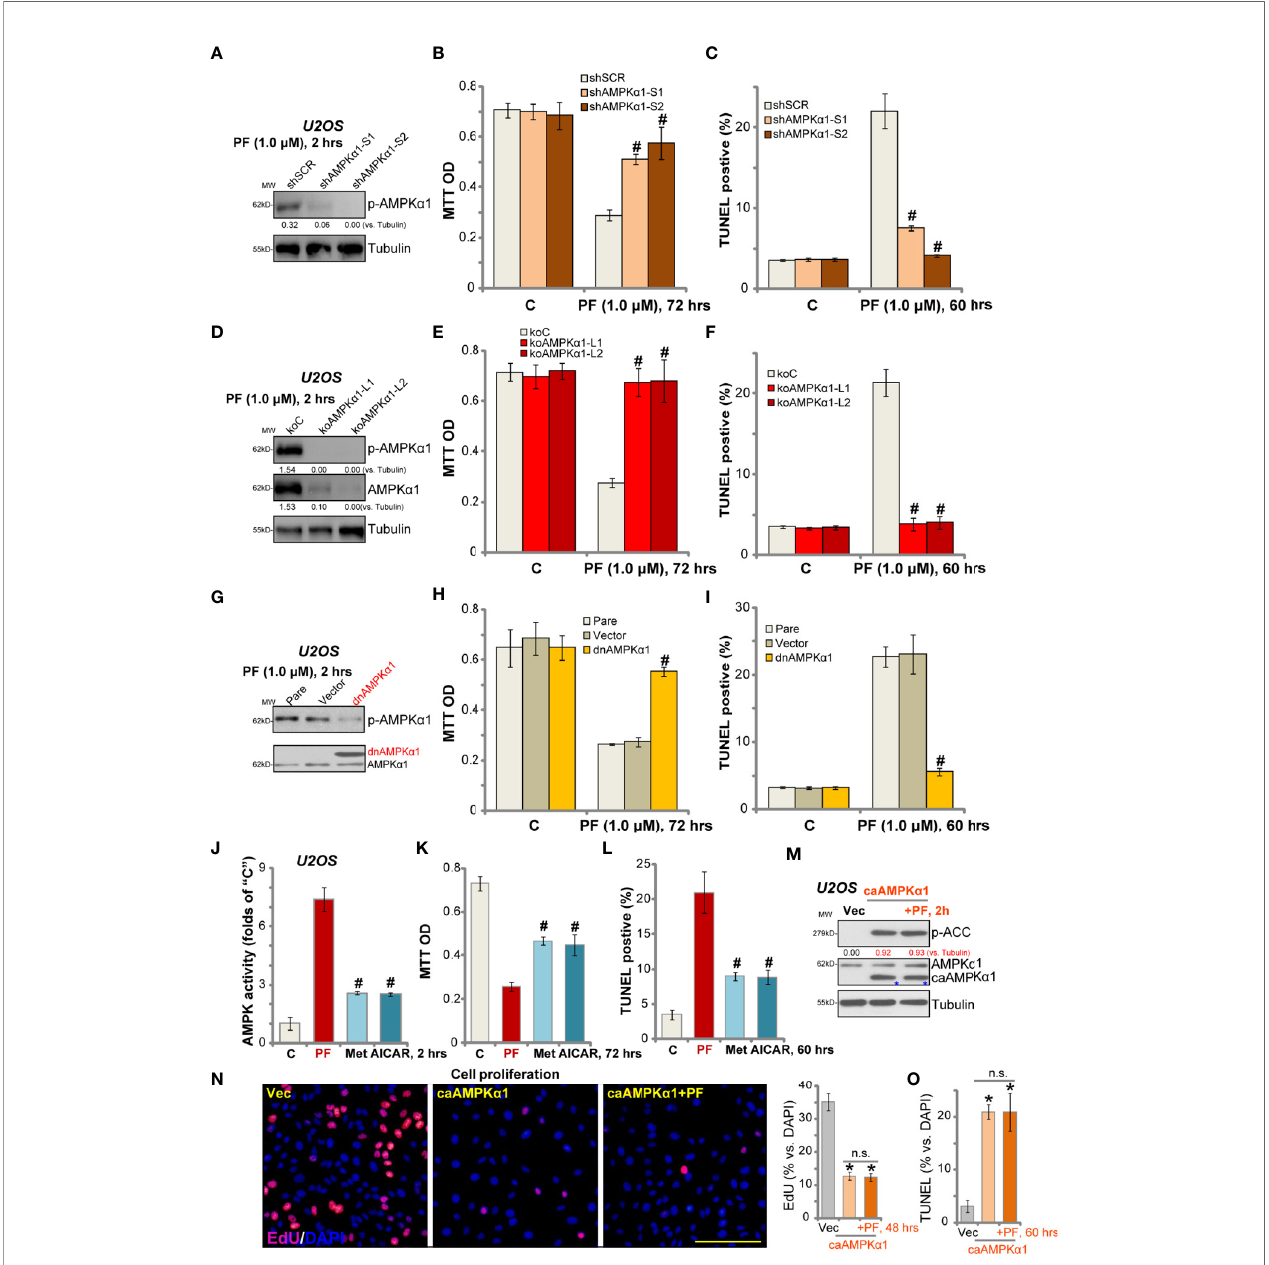
FIGURE 4 | AMPK activation mediates PF-06409577-induced activity in OS cells. Stable U2OS cells, with AMPK a 1 shRNA ( “ shAMPK a 1-S1/-2 ” ) or scramble control shRNA ( “ shSCR ” ), the CRISPR/Cas9-AMPK a 1-knockout construct ( “ koAMPK a 1-L1/L2 ” ) or the control CRISPR/Cas9 construct ( “ koC ” ), as well as the dominant negative AMPK a (T172A, “ dnAMPK a 1 ” ) or the empty vector (pSuper-puro, “ Vector ” ), were treated with PF-06409577 ( “ PF ” , 1 m M) for indicated time, expressions of listed proteins in total cell lysates were tested by Western blotting assay (A , D , G) ; Cell viability and apoptosis were tested by MTT assay (B , E , H) and TUNEL staining assay (C , F , I) , respectively. U2OS cells were treated with PF-06409577 ( “ PF ” , 1 m M), AICAR (10 mM) and metformin ( “ Met ” , 5 mM) for applied time periods, the relative AMPK activity was shown (J) ; Cell viability and apoptosis were tested by MTT assay (K) and TUNEL staining assay (L) , respectively. Stable U2OS cells-bearing the constitutive-active AMPK a 1 ( “ caAMPK a 1 ” , T172D) (M – O) were further treated with or without PF-06409577 ( “ PF ” , 1 m M), control cells were treated with the empty vector ( “ Vec ” ) (M – O) . Cells were further cultured for applied time periods, expressions of listed proteins were shown (M) ; Cell proliferation (EdU ratio, N ), and apoptosis (TUNEL-positive nuclei ratio, O ) were tested. “ Pare ” stands for the parental control cells (G – I) . Blot data was quanti fi ed and normalized to each loading control. Data were presented as mean ± standard deviation (SD). # p < 0.05 vs. control cells with PF-06409577 treatment (A – I) . # p < 0.05 vs. PF-06409577 treatment (J – L) . * p < 0.05 vs. “ Vec ” cells (N, O) . “ n.s. ” stands for non-statistical difference. Experiments were repeated three times, and each time similar results were obtained. Scale bar = 100 m m (N)